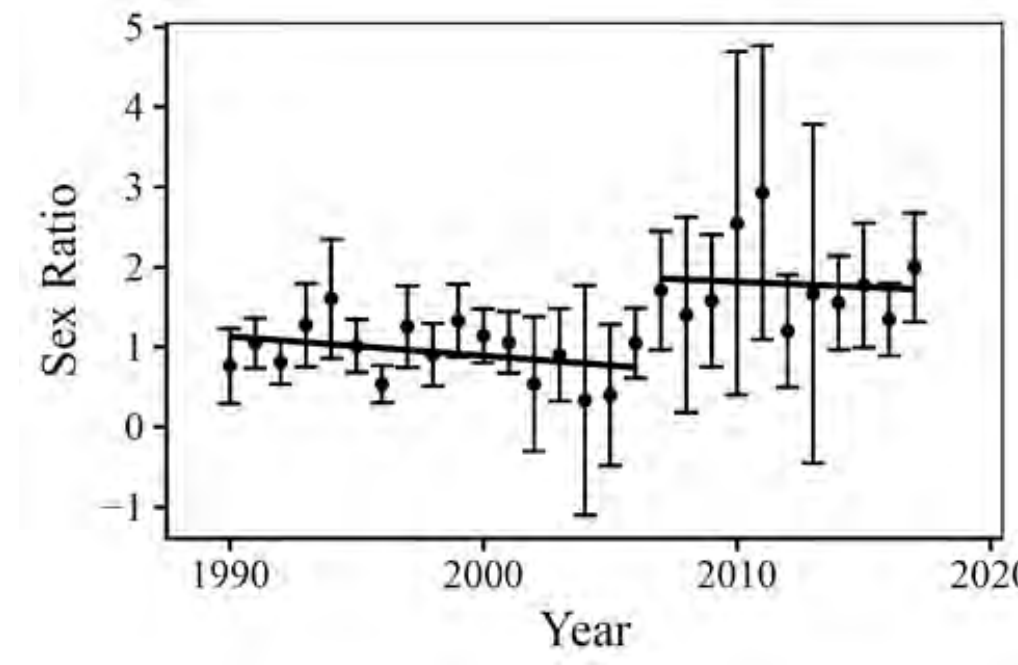
Figure 3. Annual sex ratio (M:F) and associated confidence intervals for horseshoe crabs collected in the Delaware Bay 30’ adult trawl survey from 1990 to 2017. Despite significant increases in sex ratio for these data, breakpoint analysis detected a significant shift in the relationship between these variables in